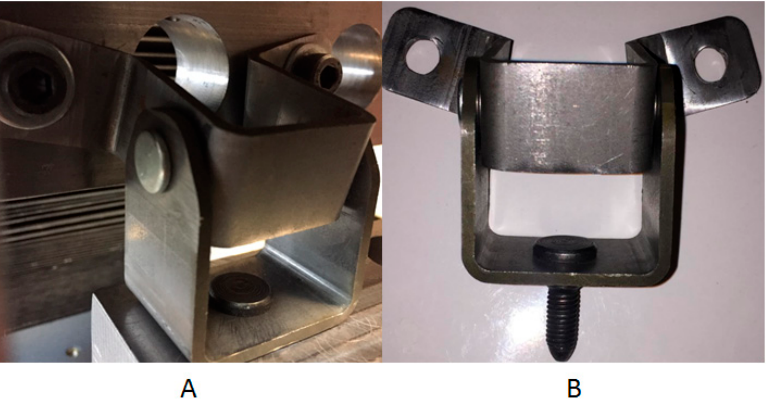
Figure 19. The appearance of test samples (( A ) sample appearance under loading, ( B ) sample appearance after test).